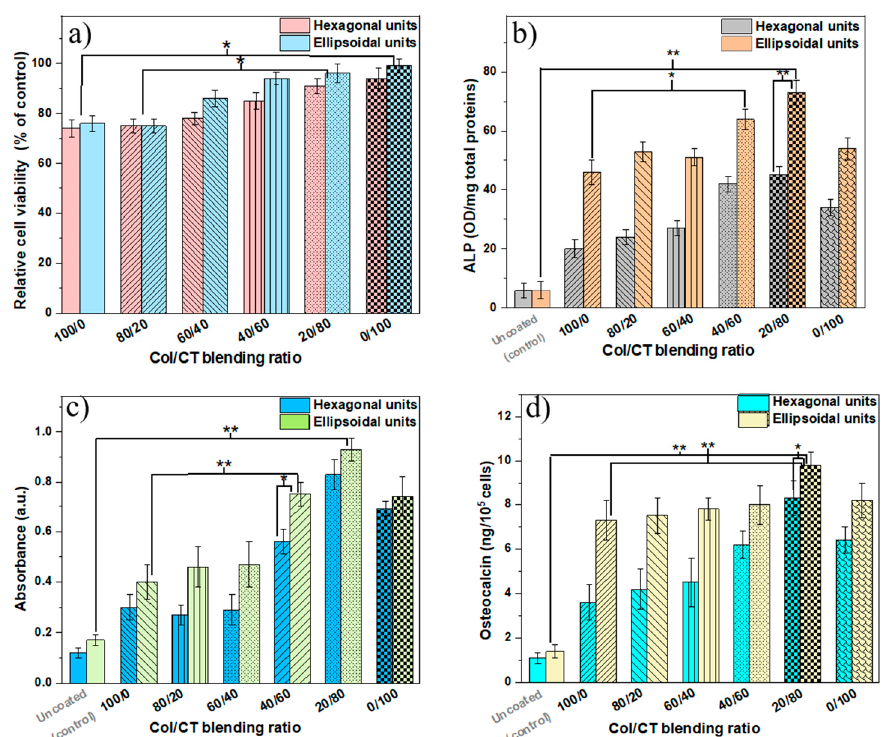
Figure 4. ( a ) Viability of cells seeded on 3D structures functionalized with Col / CT of various blending ratios The viability was measured relative to controls (uncoated) structures; ( b ) ALP activity normalized to protein content for cells seeded on 3D structures functionalized with Col / CT of various blending ratios; ( c ) Absorbance measurements for Alizarin Red marking of mineral deposits from cells seeded on 3D structures functionalized with Col / CT of various blending ratios; ( d ) Absorbance measurements for Osteocalcin secretion from cells seeded on 3D structures functionalized with Col / CT of various blending ratios. Each bar represents the mean ± STD. Statistical significance determined by Student’s test (* p ≤ 0.05; ** p ≤ 0.001).